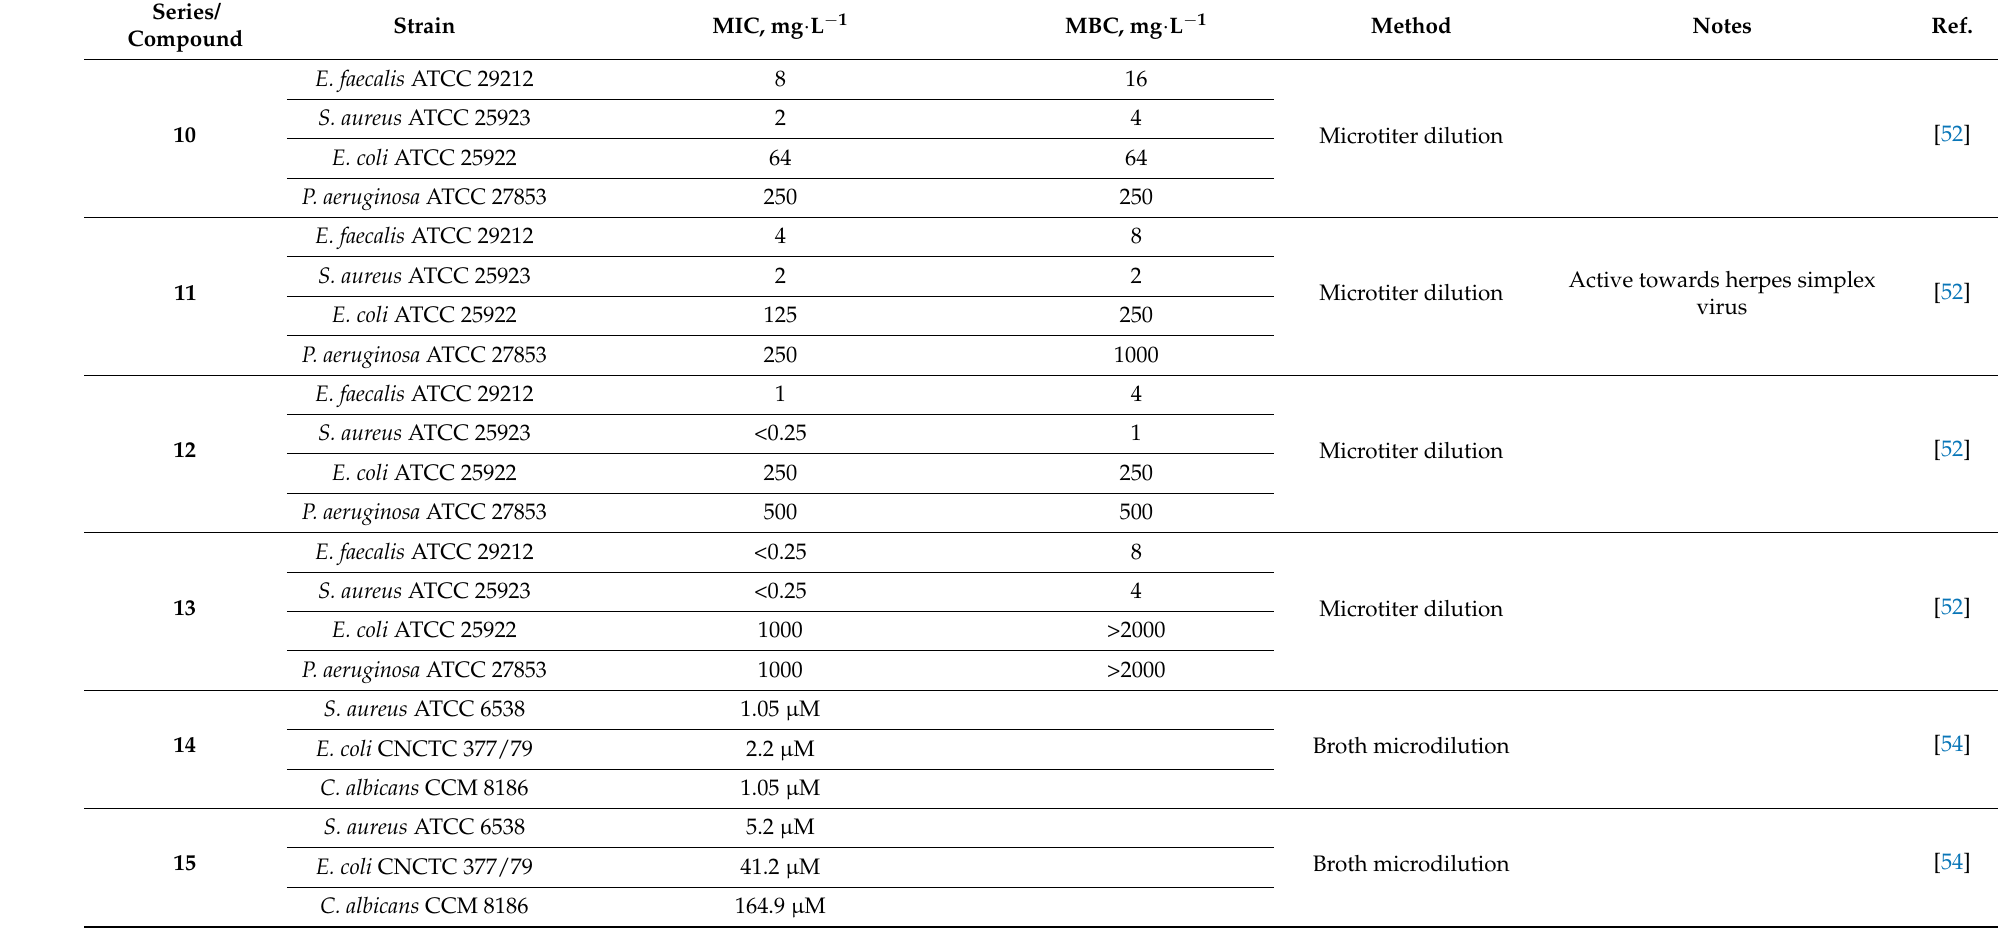
Table 1. Antimicrobial activity of mono-QACs